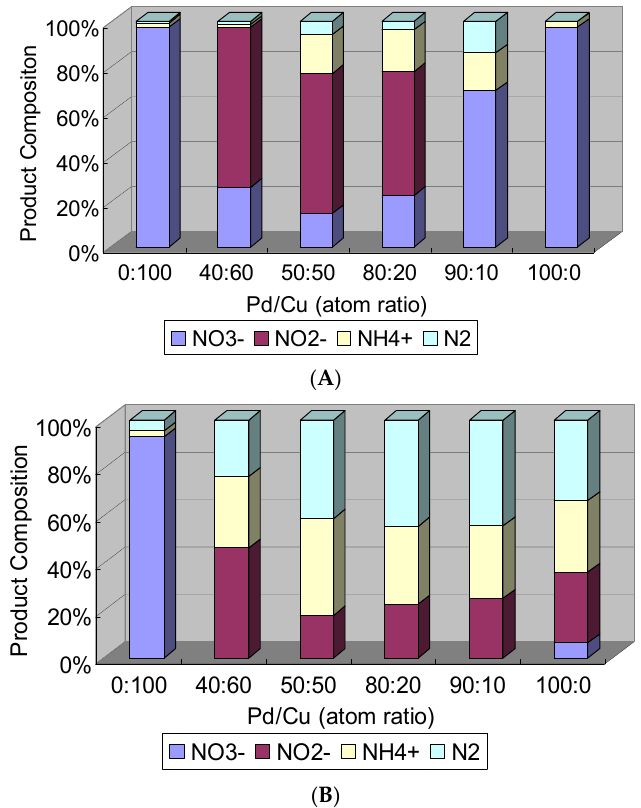
Figure 6. Product compositions of denitrification reaction catalyzed by Pd ‐ Cu/Al 2 O 3 with different Pd/Cu ratios under two different loading: ( A ) 1 wt %; and ( B ) 5 wt % metal/alloy loading samples.